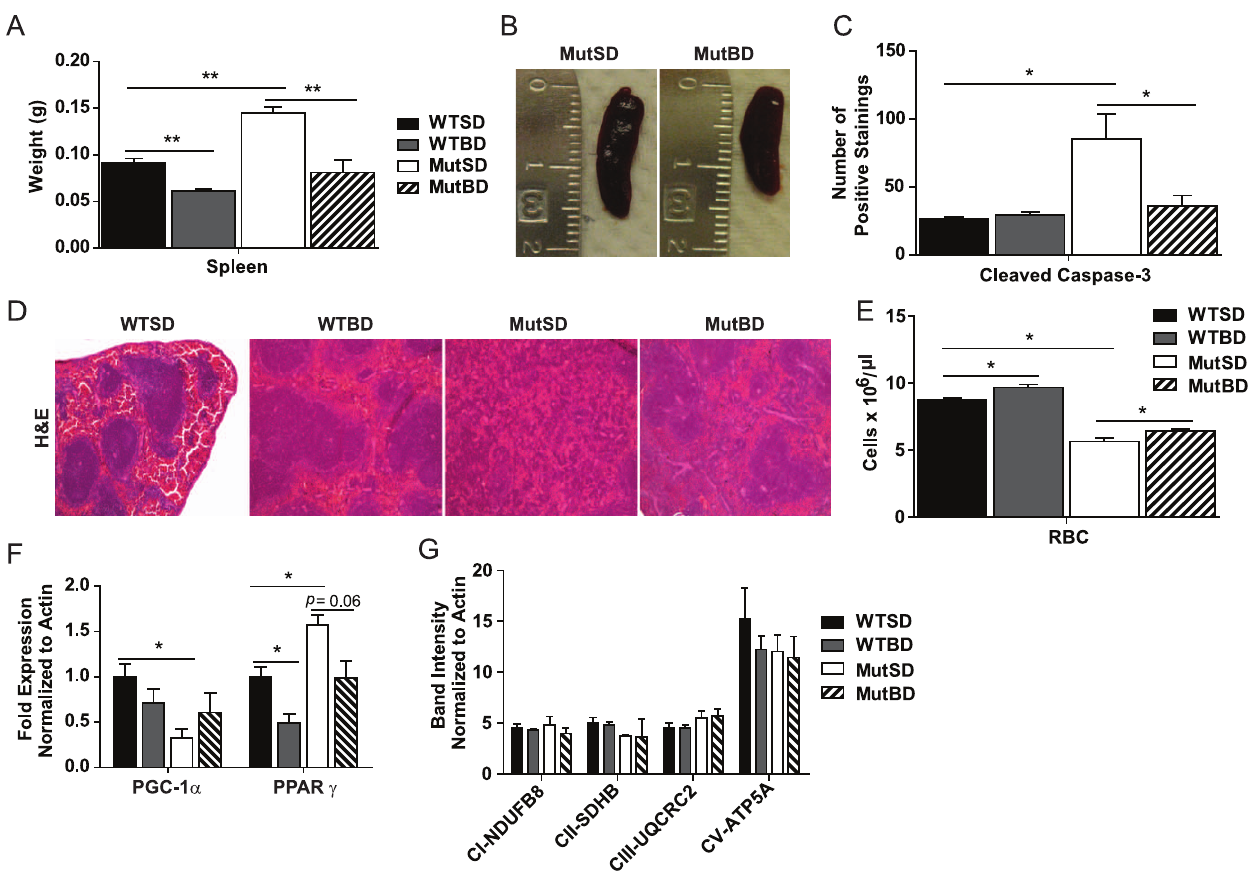
Figure 3. Bezafibrate improved spleen size and structure of Mut mice. (A) Spleen weight of 10 month-old mice and (B) picture of spleen from Mut mice (n=4–6/group). (C) Quantification of cleaved caspase-3 immunostaining in paraffin sections from the spleen of 10 month-old mice (n=3–4/group). *, P , 0.05, one-way analysis of variance followed by Bonferroni’s multiple comparison test. (D) H&E staining of the spleen of 10 month-old mice showing the organization of white pulp (purple) and red pulp (pink) (n=3/group). (E) Results from complete blood cell count in 10 month-old mice showing RBC (red blood cells, x10 6 m l ) (n=5–6/group) (F) PGC-1 a and PPAR c mRNA levels in the spleen of 10 month-old mice normalized to actin. (G) Quantification of western blot showing mitochondrial protein levels in total homogenate from the spleen of 10 month-old mice normalized to actin. NADH dehydrogenase (ubiquinone) 1 b subcomplex subunit 8 (NDUFB8; subunit of complex I), succinate dehydrogenase subunit B (SDHB; subunits of complex II), ubiquinol-cytochrome c reductase core protein 2 (UQCRC2; subunit of complex III), and ATP synthase subunit 5 a (ATP5A; subunit of complex V). *, P , 0.05; **, P , 0.01, Student’s t -test. Error bars represent the SEM.